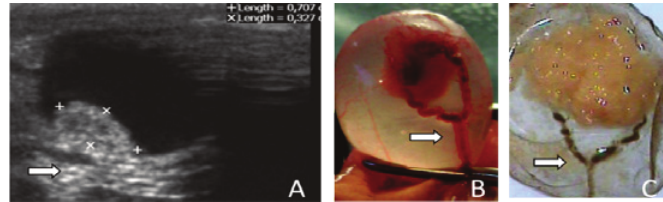
FIGURE 6 – A. Ultrasonography: image at week 40 showing tumor on posterior wall projecting into bladder. B. The same bladder (1.4 cm) transluminated in vivo showing intravesical tumor with thick and sinuous vessels adjoining. C. Open bladder with detail of cauliflower-like tumor growth in bladder wall - stereoscopic microscope - 10x.